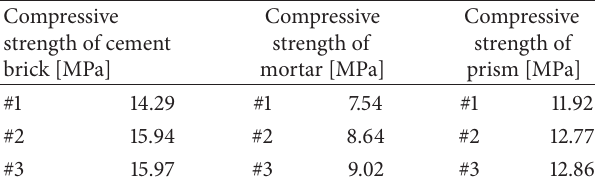
Table 3: Material properties of URM.